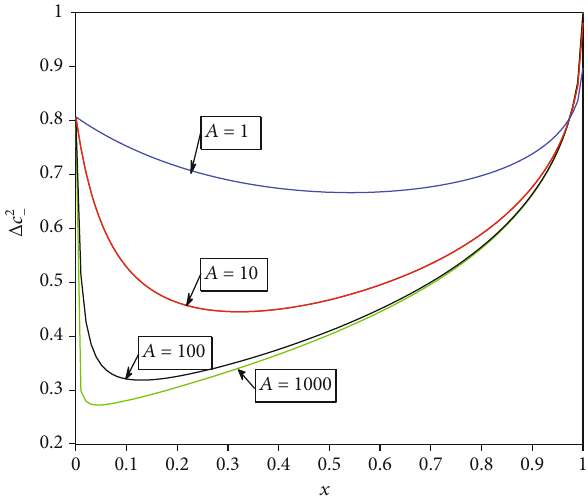
κ = 0 : 5 , ε = 0 : 06 , − versus x and for